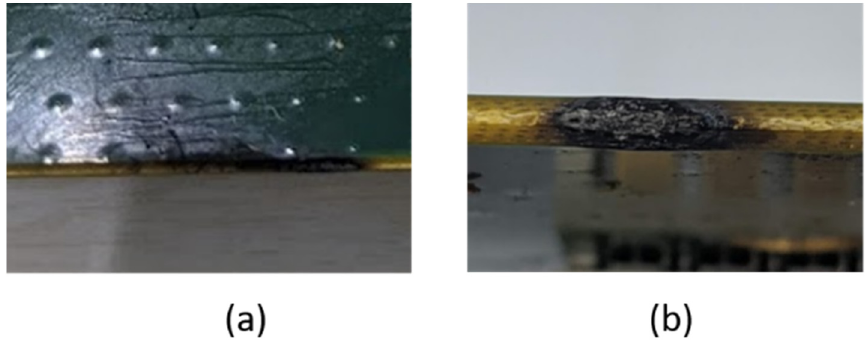
Figure 1. Visual inspection of failed PCBs: ( a ) top view; ( b ) side view.